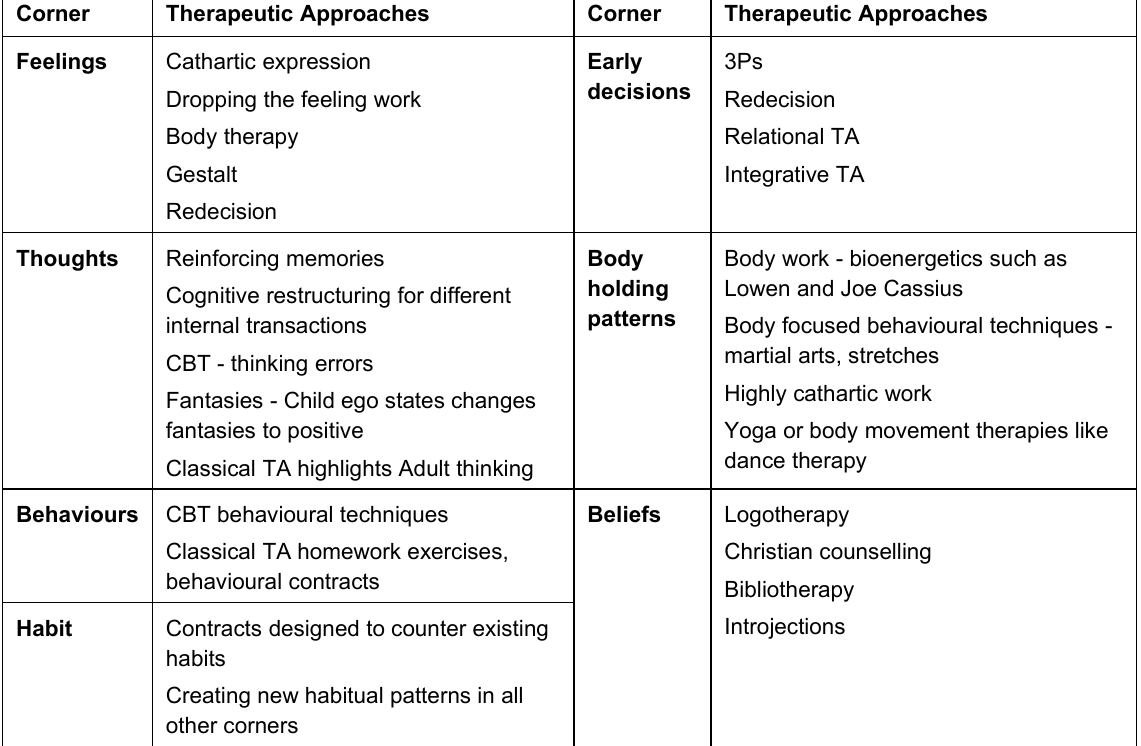
Table 2: Therapeutic Approaches for Pentagon